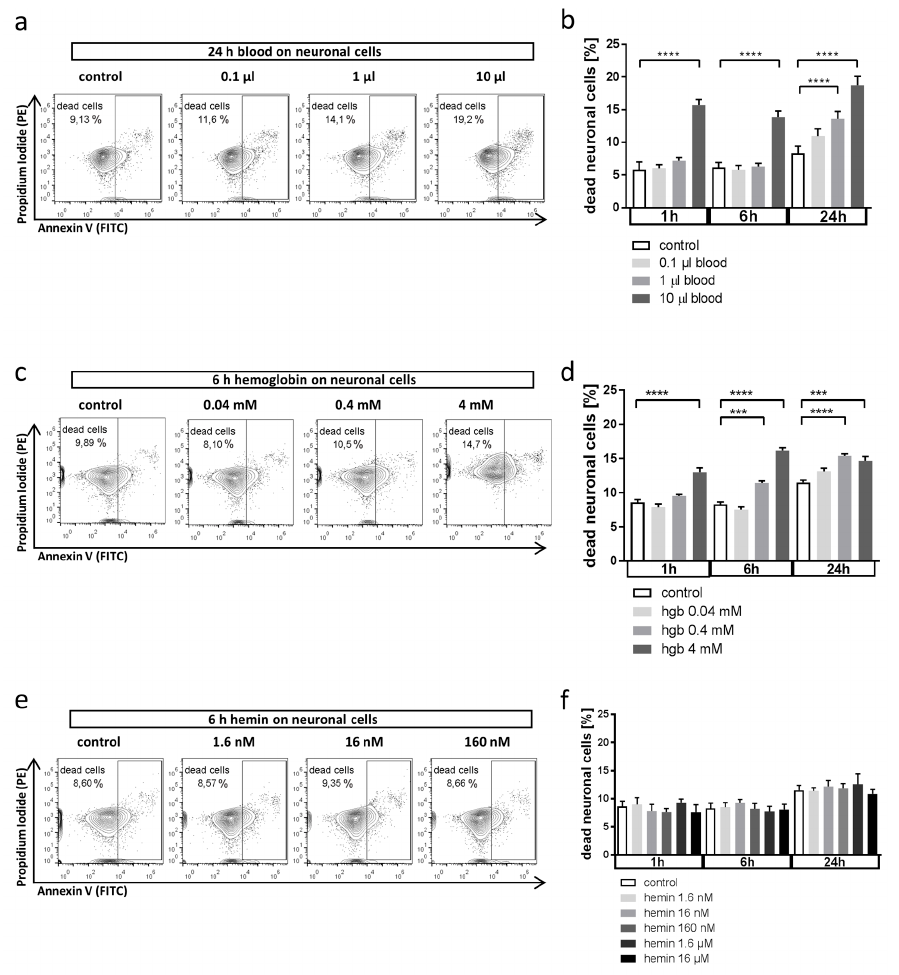
Figure 1. E ff ect of whole blood and erythrocyte components on neuronal cell death. ( a , b ) E ff ect of whole blood incubation on neuronal cell death in HT22 cells in vitro analyzed by flow cytometry after annexin V / PI staining. Cells were exposed to blood at indicated amounts (in 5 mL cell culture medium) and durations before analysis (( a ) representative flow cytometry plots; propidium iodide (PI) was detected in the PE channel and annexin V in the FITC channel; ( b ) quantification as % dead cells from total of n = 6 experiments). **** p < 0.0001 control vs. 10 µ L blood 1 h, **** p < 0.0001 control vs. 10 µ L blood 6 h, **** p < 0.0001 control vs. 1 µ L 24 h, **** p < 0.0001 control vs. 10 µ L 24 h. ( c , d ) E ff ect of hemoglobin exposure on neuronal cell death in HT22 cells in vitro analyzed by flow cytometry after annexin V / PI staining. Cells were exposed to hemoglobin at indicated concentrations corresponding to the volumes of blood used in ( a , b ) (( c ) representative flow cytometry plots; ( d ) quantification as % dead cells from total of n = 6 experiments). **** p < 0.0001 control vs 4 mM hemoglobin 1 h, *** p = 0.0002 control vs. 0.4 mM hemoglobin 6 h, **** p < 0.0001 control vs 4 mM hemoglobin 6 h, **** p < 0.0001 control vs. 0.4 mM hemoglobin 24 h, *** p = 0.0002 control vs 4 mM hemoglobin 24 h. ( e , f ) E ff ect of hemin on neuronal cell death in HT22 cells in vitro analyzed by flow cytometry after annexin V / PI staining. Cells were exposed to hemin at indicated concentrations corresponding to the volumes of blood used in ( a , b ) (( e ) representative flow cytometry plots; ( f ) quantification as % dead cells from total of n = 6 experiments). p = n.s. for all